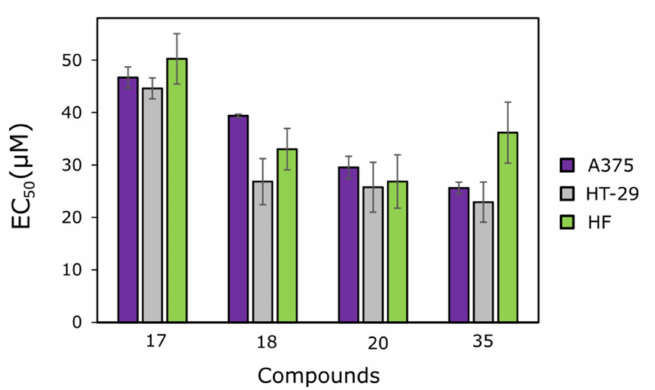
Figure 2. EC 50 values of the most active compounds: 17 , 18 , 20 and 35 . Cell lines were incubated with different concentrations of those compounds for 72 h. The cytotoxicity was measured using MTT assays. The cytotoxicity is represented as the calculated half maximal effective concentration (EC 50 value). N =